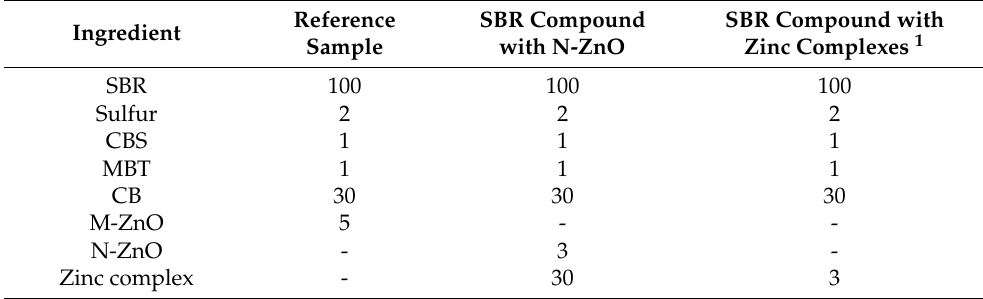
Table 2. Amount of zinc in SBR compounds containing different vulcanization activators. Amount of Zinc in Activator Amount of Zinc in SBR Activator (mmolg)